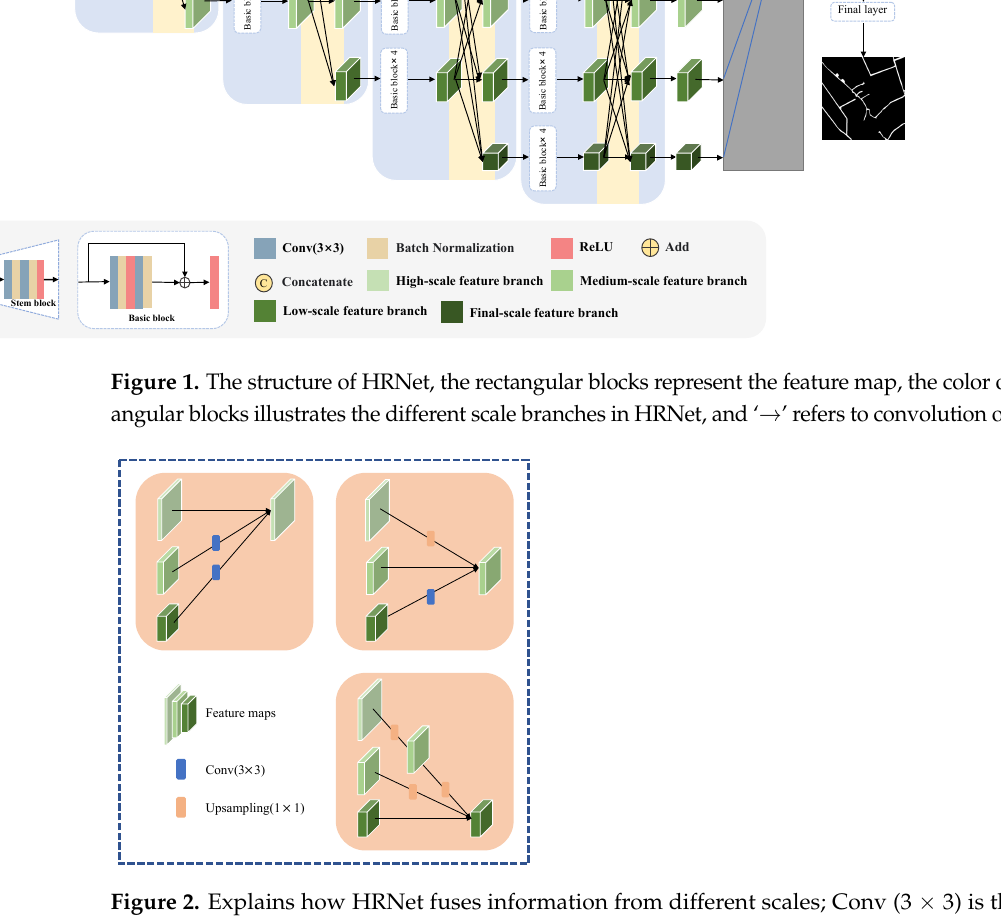
Figure 2. Explains how HRNet fuses information from different scales; Conv (3 × 3) is the convo- lution of stride 3 × 3 and upsampling (1 × 1) is the combination of nearest neighbor interpolation upsampling and 1 × 1